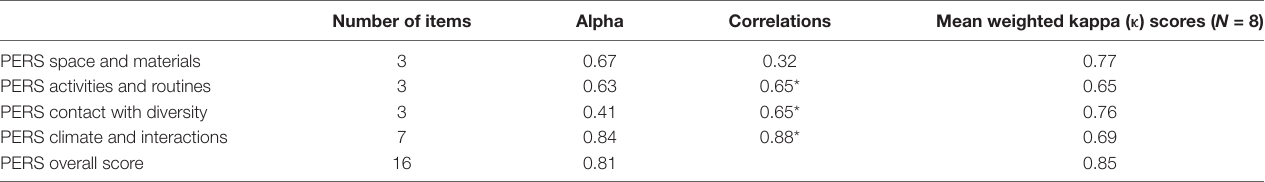
TABLE 5 | Cronbach’s alpha, correlations for PERS subscales and overall score and inter-rater agreement of the measure’s dimensions and overall score.